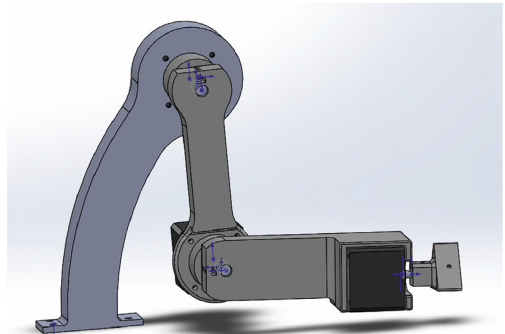
Figure 2: Robot arm 3D model.